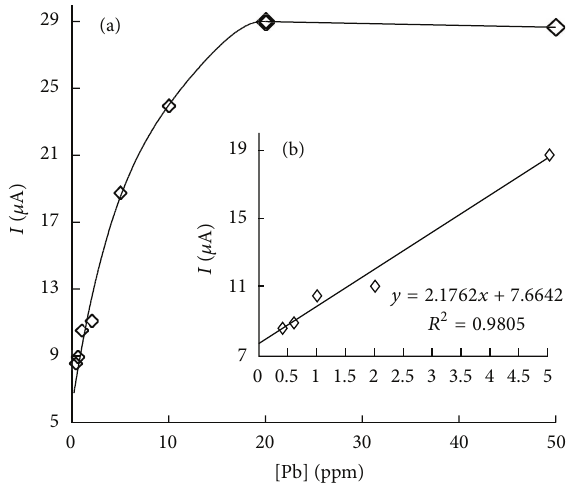
Figure 2: Effect of various preconcentration Pb(II) standards for the Acetabularia -CPE showing the (a) full range from 0.4ppm to 50 ppm and (b) linear increase from 0.4 ppm to 5ppm, under the conditions of one minute accumulation, followed by a deposition potential of − 800 mV and a scan rate of 75mV/s in 0.1MKNO 3 electrolyte.